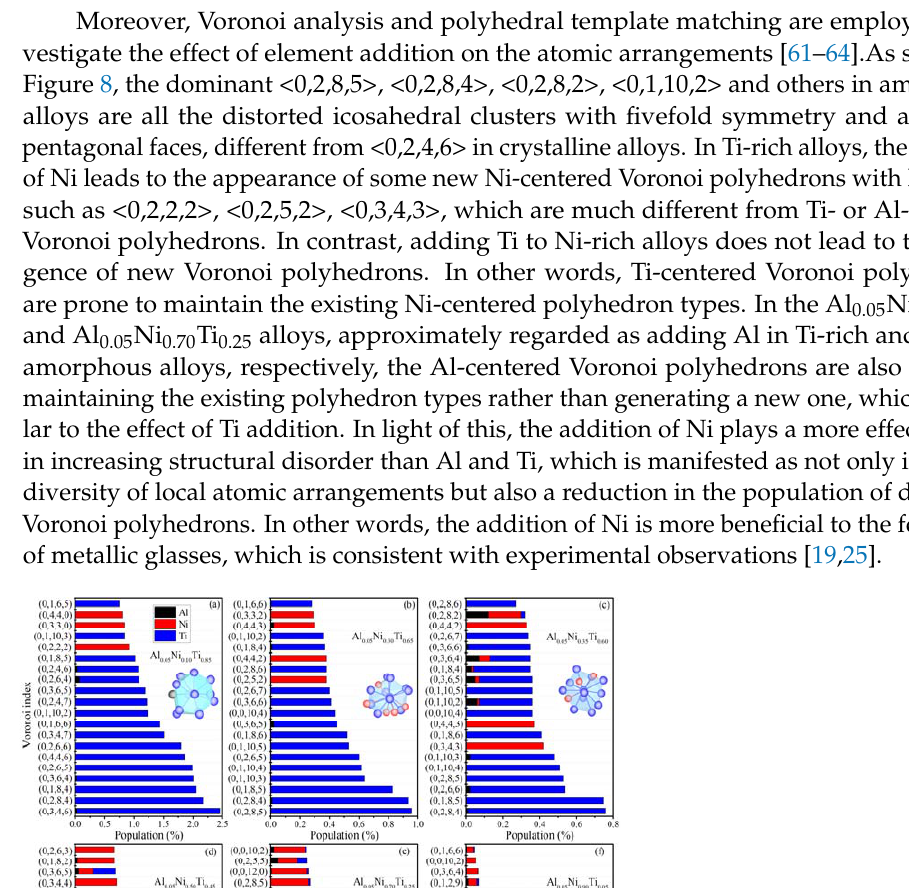
Figure 8. Populations of the most dominant Voronoi polyhedrons obtained from MD simulations and the coordination cluster with the highest population for alloys:( a ) Al 0.05 Ni 0.10 Ti 0.85 , ( b ) Al 0.05 Ni 0.30 Ti 0.65 , ( c ) Al 0.05 Ni 0.35 Ti 0.60 , ( d ) Al 0.05 Ni 0.50 Ti 0.45 , ( e ) Al 0.05 Ni 0.70 Ti 0.25 , ( f ) Al 0.05 Ni 0.90 Ti 0.05 .